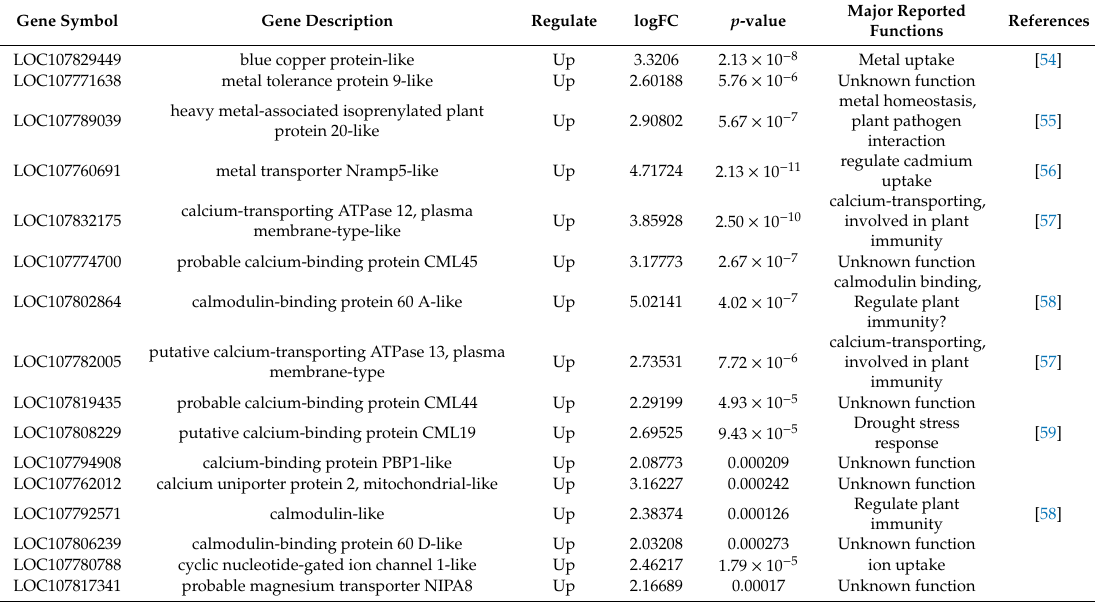
Table 3. Metal signaling responsive genes induced by NNM.